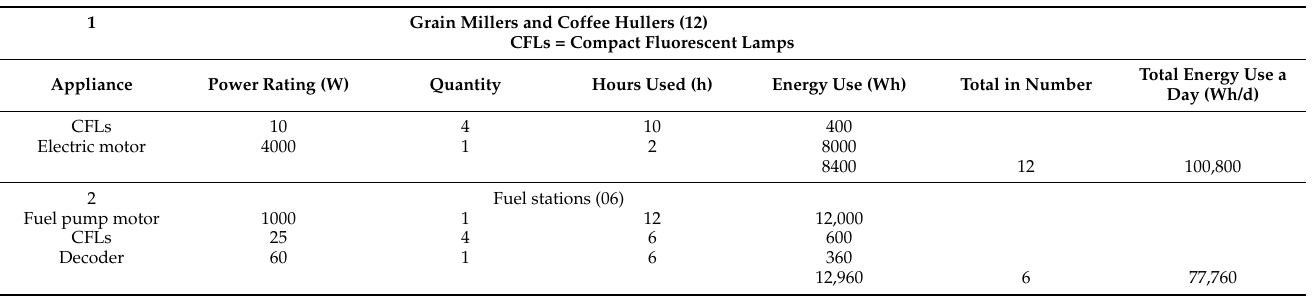
Table 3. Determining total daily energy demand of KHMG